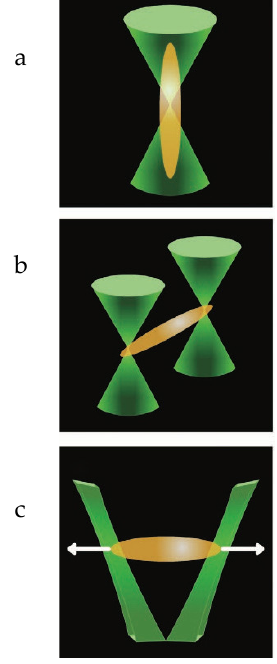
Figure 4. Examples of optical stretching assays. ( a ) Stretching assay utilizing a single optical trap. ( b ) A dual optical trap stretching assay. ( c ) Stretching assay utilizing a double optical trap with lateral force projections [33]. Reprinted from Ref.